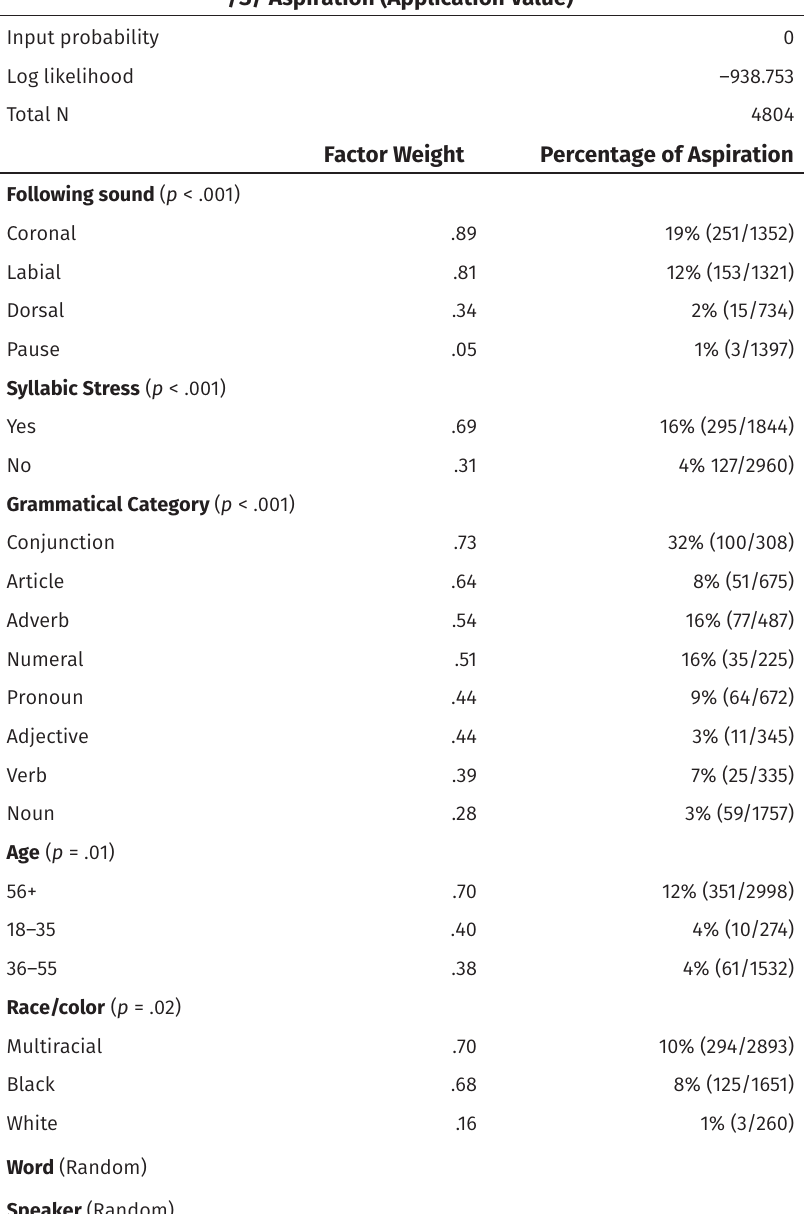
Table 2: Run 2 of the logistic regression analysis for /s/